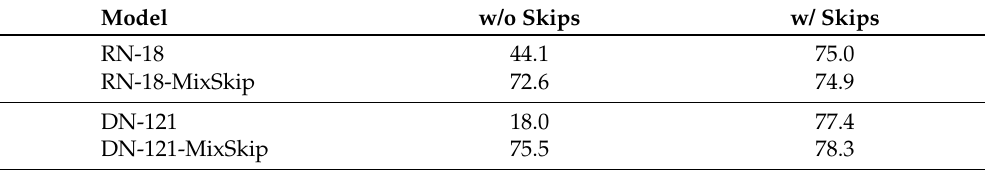
Table 1. Evaluation (mIoU) of semantic segmentation models with and without skip connections on Cityscapes val. Models are trained with regular or mix-skip